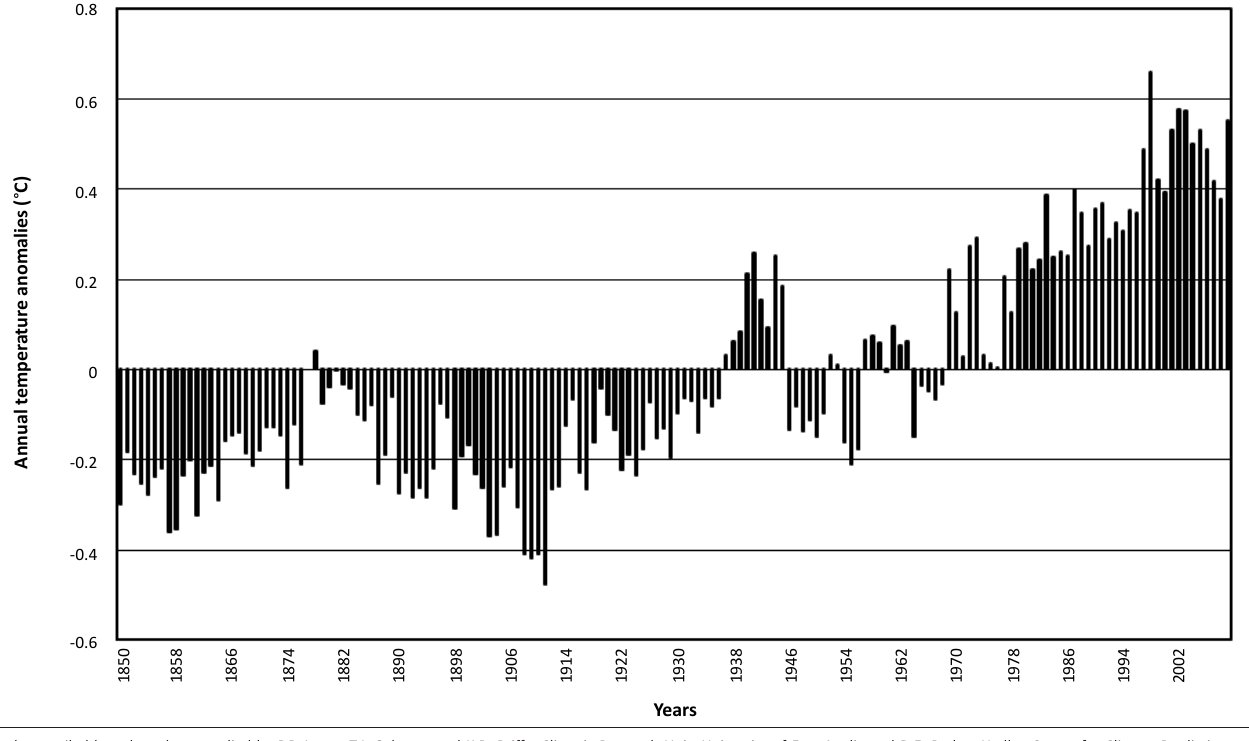
FIGURE 2: Southern hemisphere surface air temperature anomalies between 1850 and